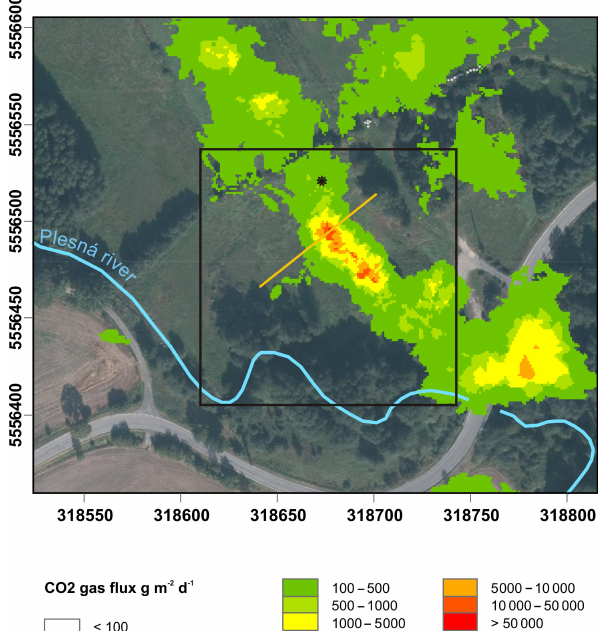
Figure 3. Location of the ICDP drill HJB-1 (black star) in the Hartoušov mofette field, with CO 2 gas flux mapping results of Nickschick et al. (2015). The black rectangle shows the area of pas- sive seismic noise measurements (Fig. 6 and Sect. 5.3; matched field processing, MFP). The location of the geoelectrical profile in Fig. 5 is indicated by the orange line. Coordinates are in UTM zone